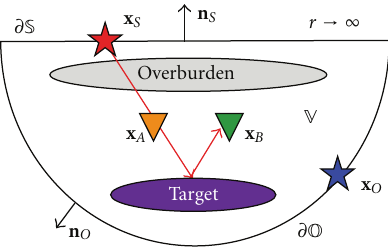
Figure 2: Configuration for controlled-source interferometry by cross-correlation of full fields; volume V is enclosed by the source array ∂ S and an additional half sphere ∂ O whose radius r → ∞ ; x S denotes a source location at ∂ S and n S is the unit normal vector of this surface; x O denotes a source at ∂ O and n O is the unit normal vector of this surface; heterogeneities between sources and receivers are referred to as “overburden,” whereas heterogeneities below the receivers are referred to as